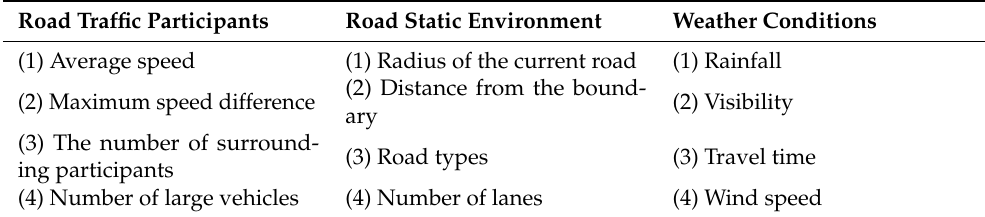
Table 1. Influencing